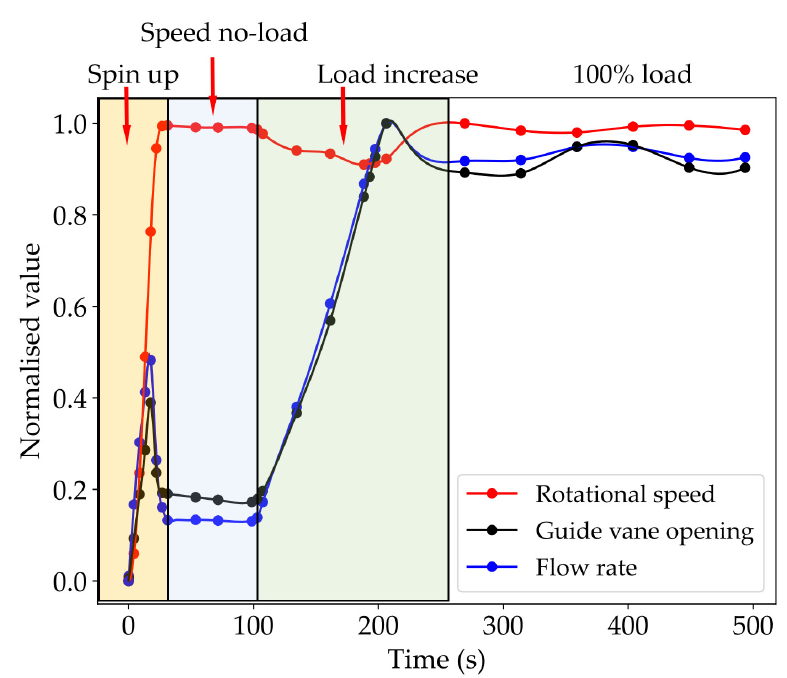
Figure 5. The operating parameters of the PT unit during turbine start-up. The relative pressure distribution of the PT flow channel during turbine start-up is shown in Figure 6. It can be seen from Figure 6 that as the guide vane opening increases during turbine start-up, the flow rate gradually increases. From t = 0 s to t = 8.8 s, the pressure of the spiral case gradually increases through the stay ring to the inner surface of the head-cover. When the rotational speed is close to the rated speed, the guide vanes will be slightly closed to prevent over speed. The fluid pressure in the spiral case and stay ring area decrease significantly until t = 31.2 s. As the guide vanes open further, the speed of the turbine gradually increases. From t = 53.7 s to t = 161.4 s, the pressure on the inner surface of the spiral case, the stay ring and the head-cover increases again, and from t = 188.3 s to t = 197.3 s, the pressure slightly declines. The PT unit operates stably until the guide vane opening, the flow rate, the rotational speed and the torque of the unit no longer change, and the pressure in the flow channel remain relatively stable.